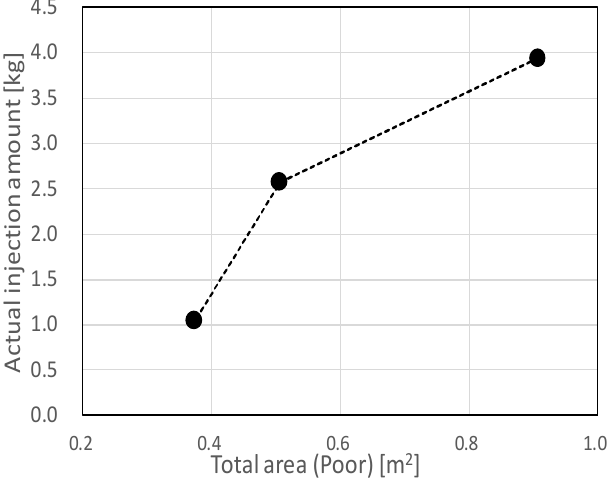
Figure 8. Total area (Poor) vs. injection amount.